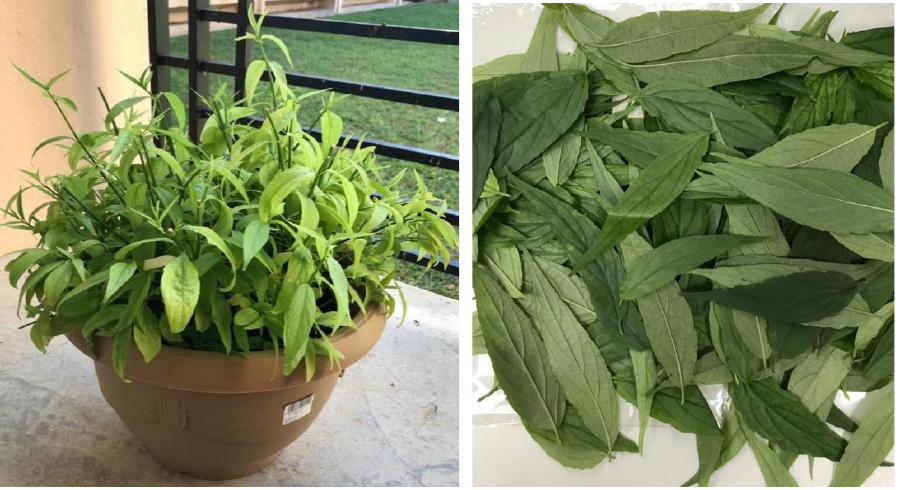
Figure 1. Image of C. nutans plants and leaves.